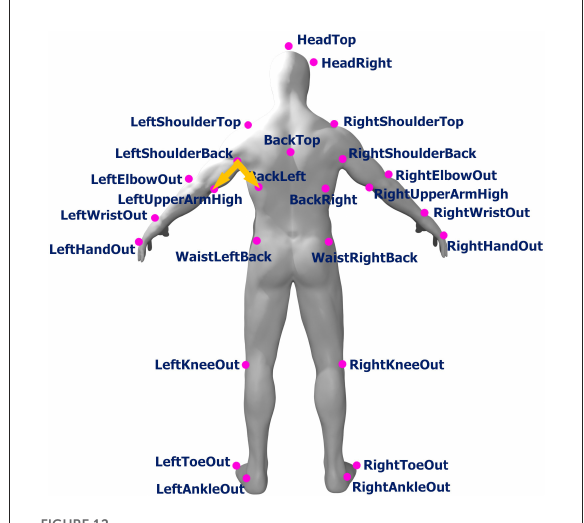
FIGURE12 Angle of BackLeft-LeftShoulderBack-LeftUpperArmHigh (arm swing) in body skeleton image (original human figure source: dox012 on Sketchfab 4